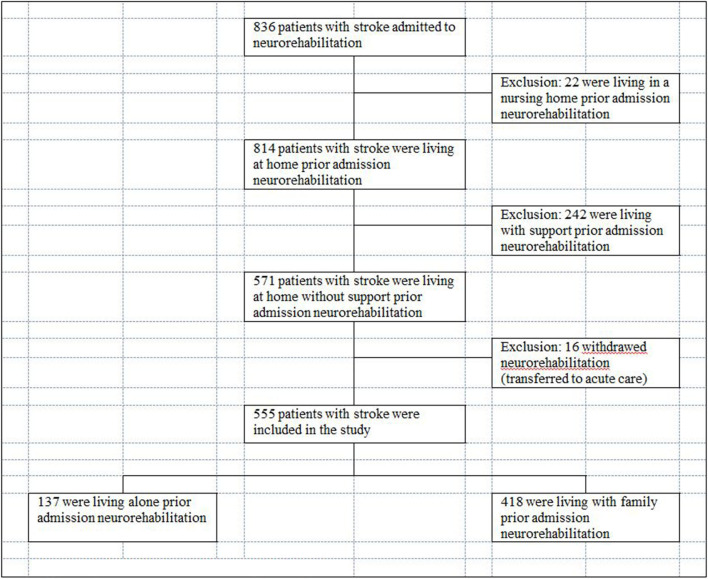
Flow chart—patient sample study 1.